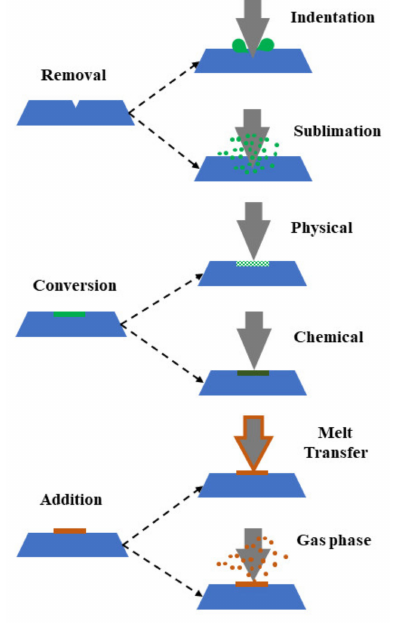
Figure 4. Schematic diagram of scanning probe